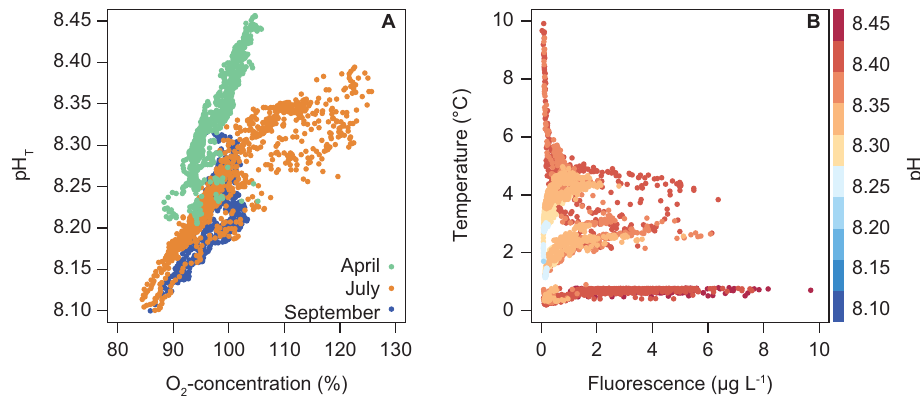
Figure 3. Fjord-scale relationships in Kobbefjord between pH and oxygen (a) , and between temperature and fluorescence with associated pH levels shown with symbol colour (b) , on three sampling occasions: 19 April, 18 July and 3 September